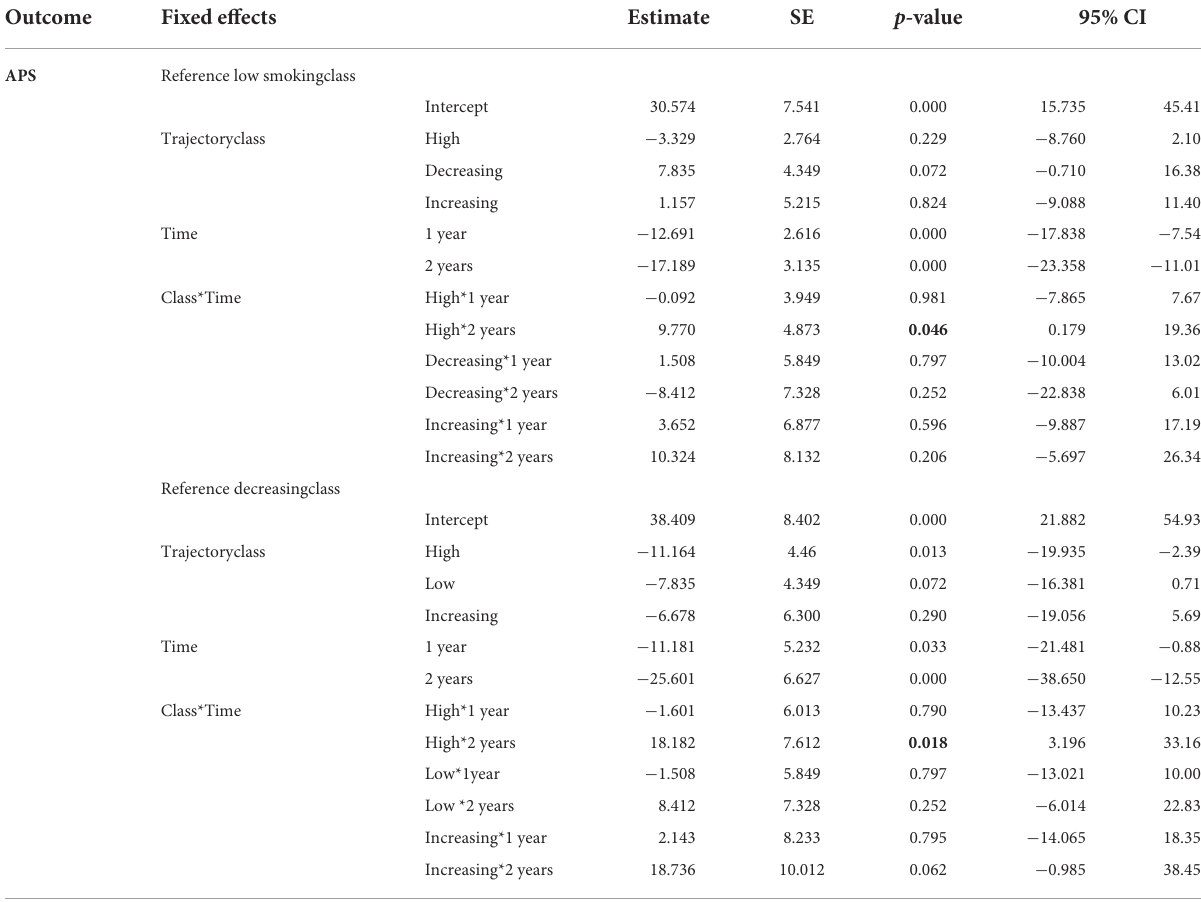
TABLE 3 Results of mixed model analyses of the effect of trajectory class membership on attenuated positive symptoms (APS).